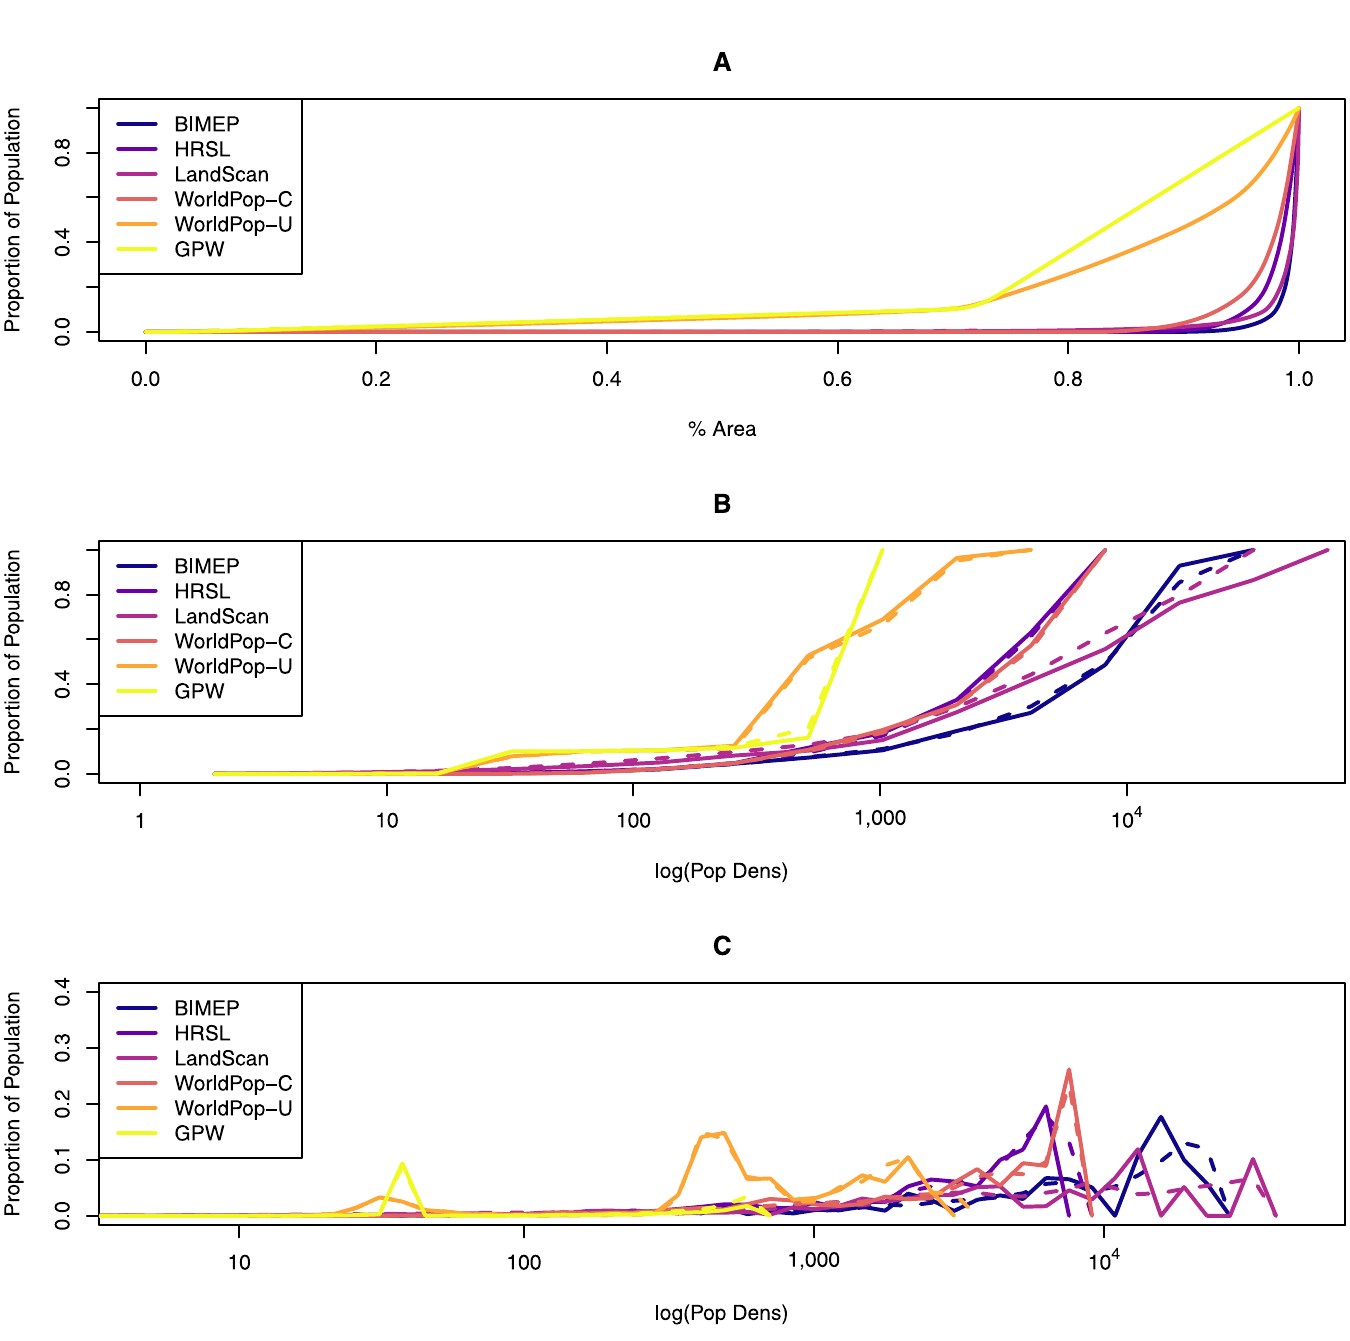
Fig 5. A comparison of the distributions by land area and population density. Solid lines are 1x1 km maps, and dashed lines are 100x100 m maps. A) To show how the population is distributed, we plotted the empirical cumulative distribution functions (eCDFs) of population density by land area; B) To show how the population is aggregated, we plotted the eCDFs by log population density. C) The population density binned by powers of 1.2. https://doi.org/10.1371/journal.pone.0248646.g005 (Fig 6). Of these metrics, the maximum population is most sensitive to grid placement, espe- cially for the coarsest grid choice. The BIMEP and HRSL maps were the most similar across all three binary metrics. LS and WP-C had a much higher fraction of pixels in the lowest popula- tion category (Fig 6A). Overall, the HRSL tended to be the most accurate and with the best recall for population densities up to 5,000 per km 2 , which was the upper limit of population